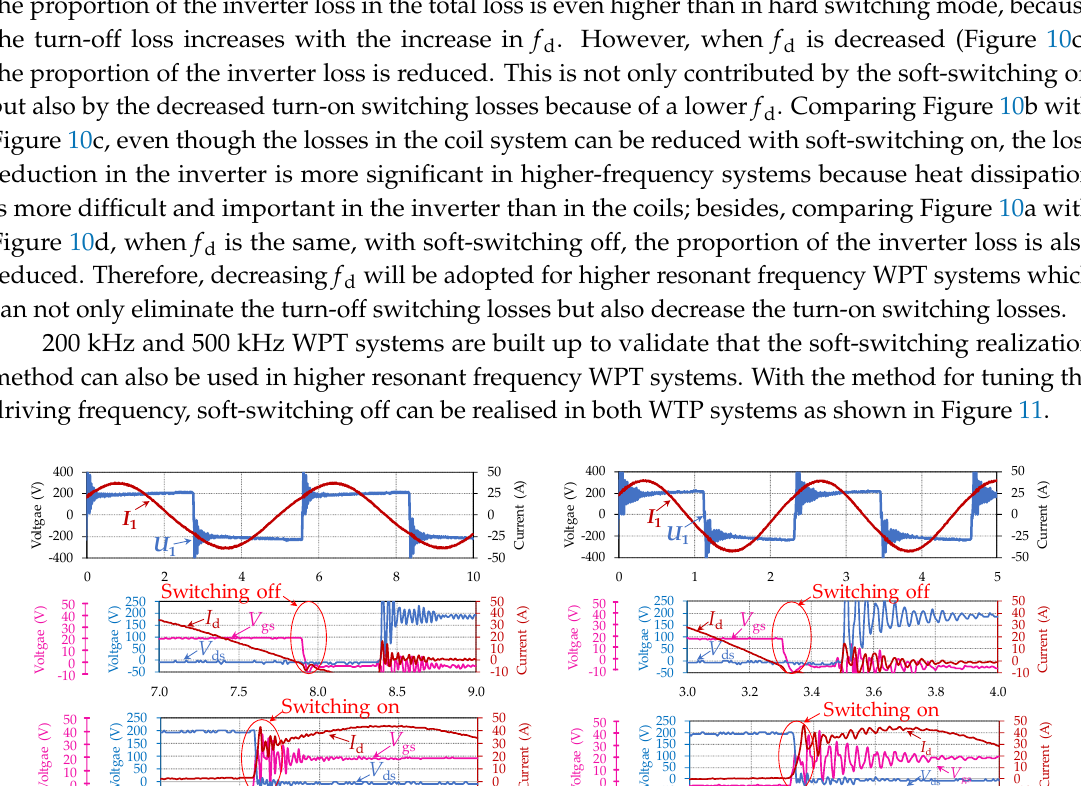
Figure 10. Loss distribution of the 85 kHz WPT system: ( a ) 85 kHz@85 kHz; ( b ) 95 kHz@85 kHz; ( c ) 80 kHz@85 kHz; ( d ) 85 kHz@95 kHz.